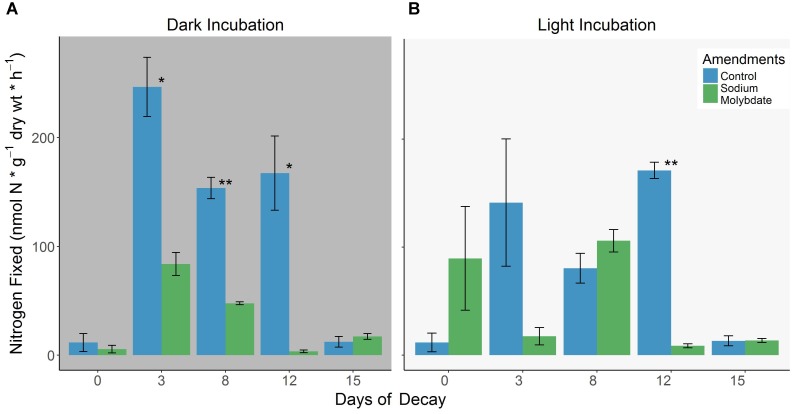
(A,B) Differences in BNF rates associated with decomposing S. horneri between control conditions and sodium molybdate (20 mM) additions under dark (left) and light (right) incubations (error bars represent SE). ∗p < 0.05, ∗∗p < 0.01.